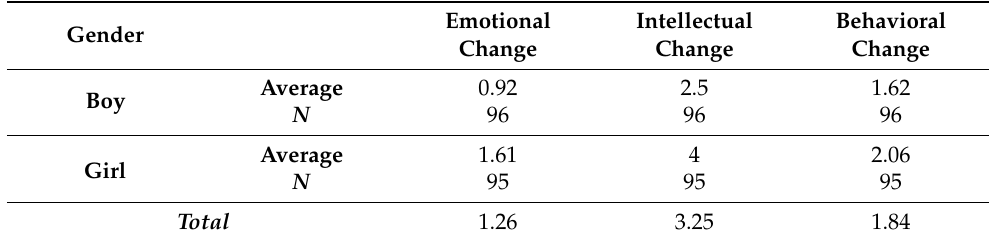
Table 7. Gender-specific difference among the